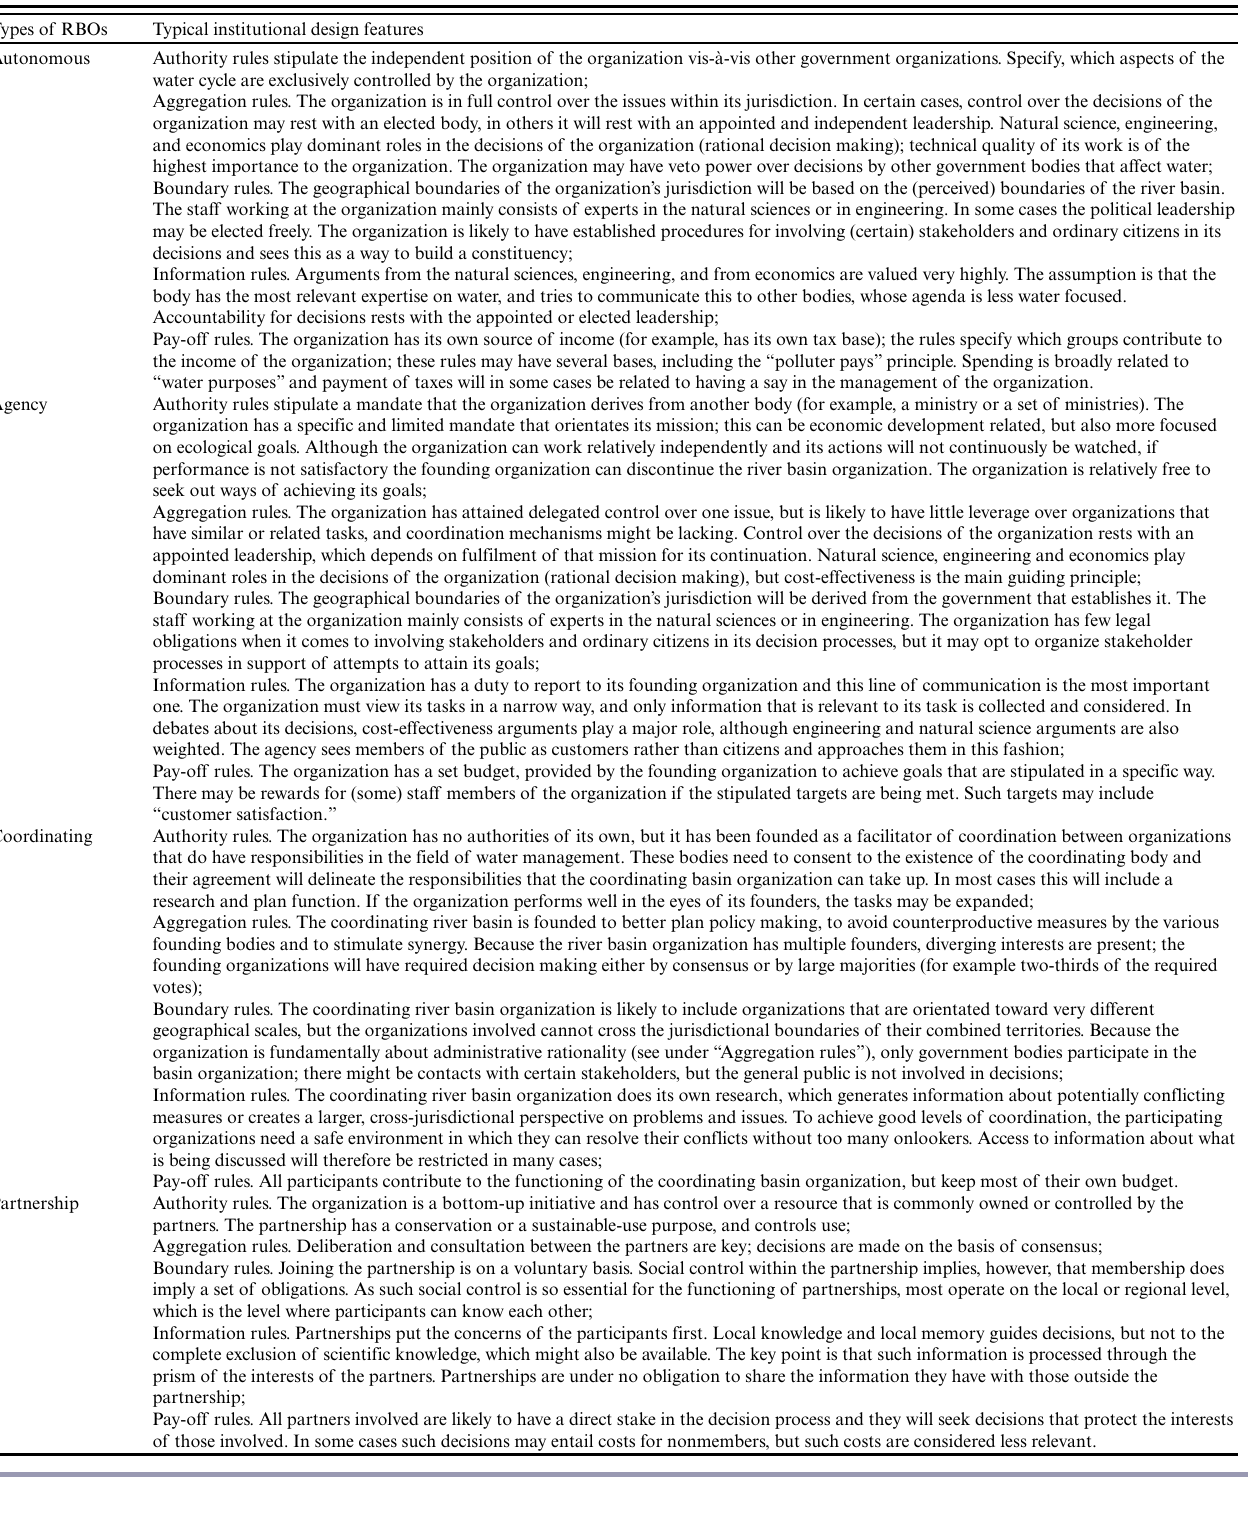
Table 1 . Typology of river basin organizations (RBOs) used in our